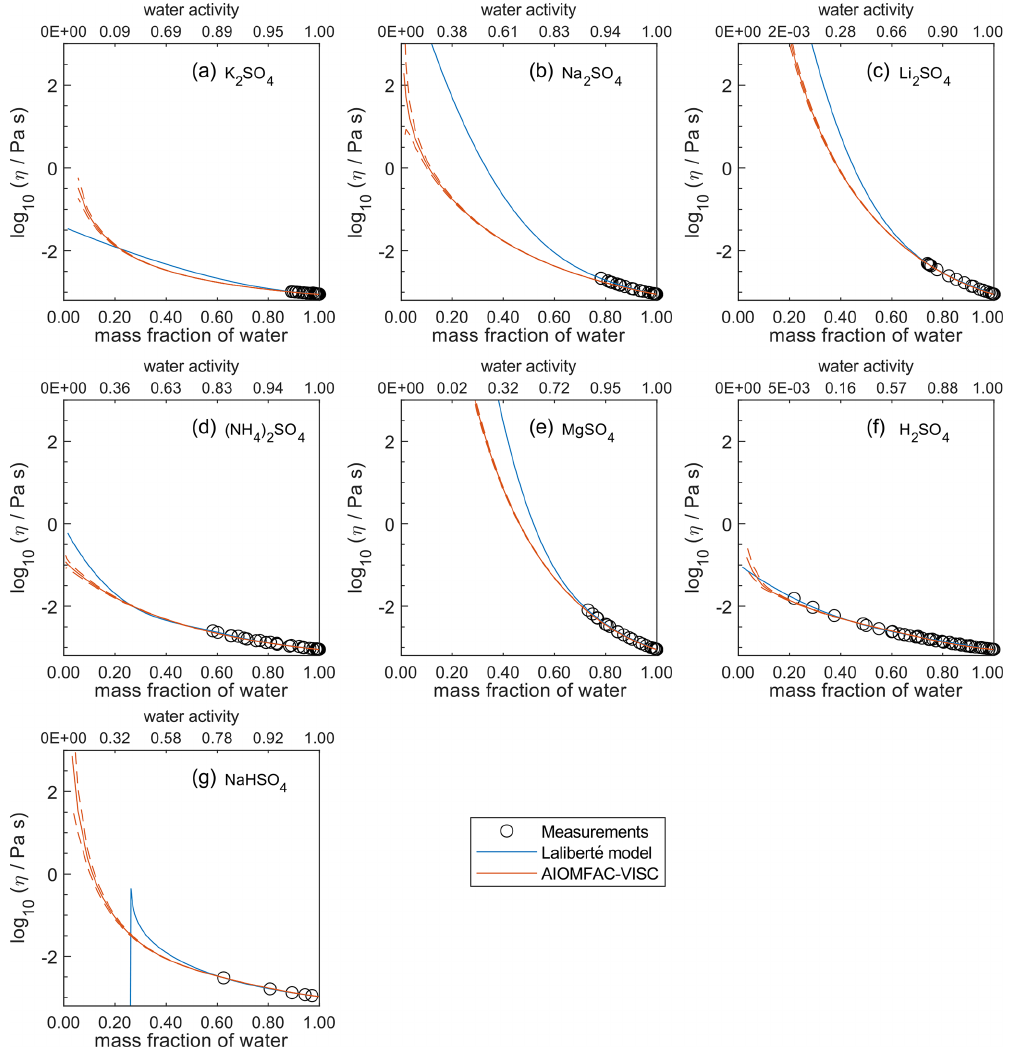
Figure 5. Comparison of the Laliberté model, AIOMFAC-VISC, and viscosity measurements versus mass fraction of water (bottom axis) and AIOMFAC-predicted water activity (top axis) for binary solutions of sulfate salts at 298K with bulk measurements shown for 298 ± 1K unless otherwise indicated: (a) K 2 SO 4 , (b) Na 2 SO 4 , (c) Li 2 SO 4 , (d) (NH 4 ) 2 SO 4 , (e) MgSO 4 , (f) H 2 SO 4 , and (g) NaHSO 4 (291K). See Fig. S7 for a zoomed-in version of this figure. See also caption to Fig.